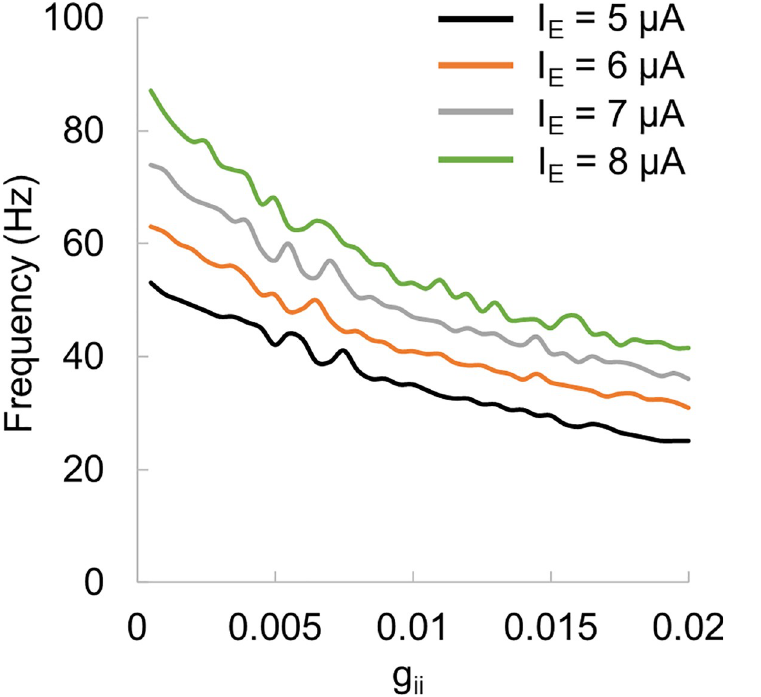
Fig 13. Model output frequency as a function of connectivity strength between